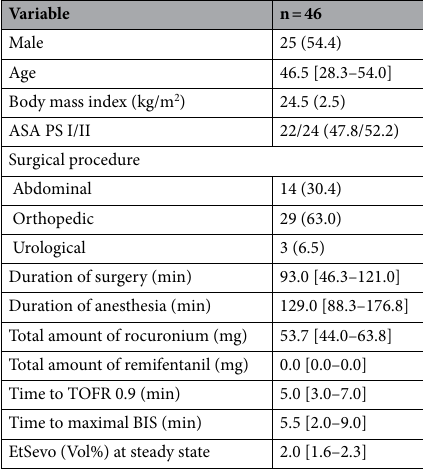
Table 1. Baseline characteristics and intraoperative data. Data expressed as mean (SD), median [IQR], or n (%). ASA PS American Society of Anesthesiologists’ physical status, TOFR train of four ratio, BIS bispectral index, EtSevo end-tidal sevoflurane concentration.